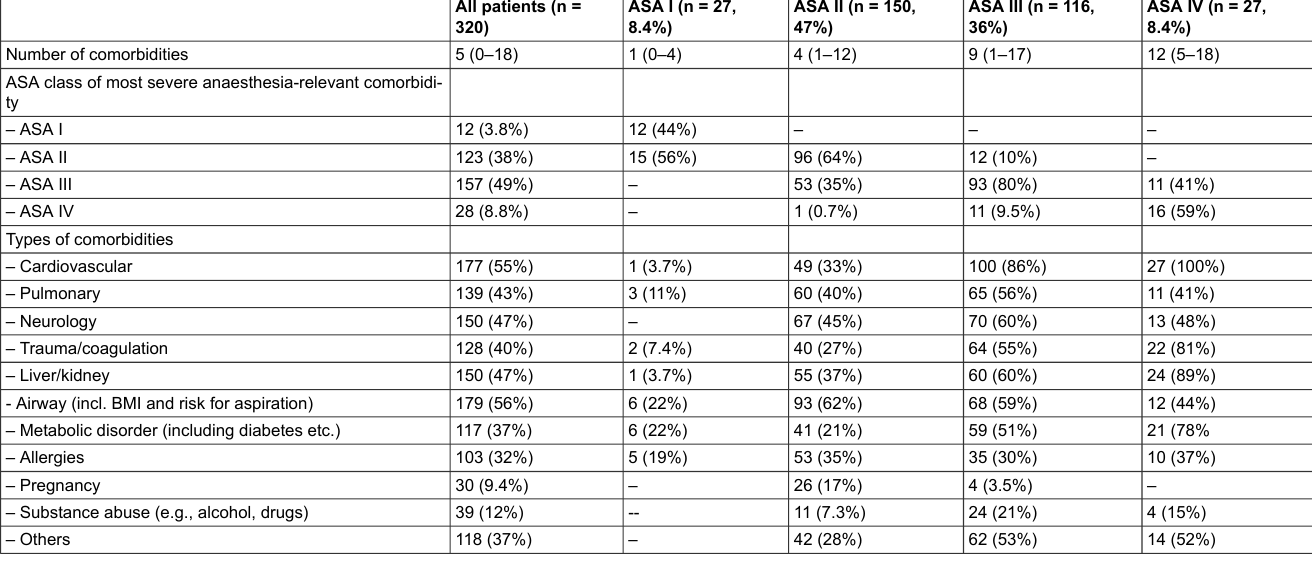
Table 2: Comorbidities for the total study population (n = 320) and for the different ASA PS classes This table gives an overview of the number and severity of anaesthesia-relevant comorbidities. An ASA class was assigned to each comorbidity by the study team. The columns correspond to the overall ASA PS classes as preoperatively assigned by the treating anaesthesiologists. Quantitative variables are reported as median (IQR), quantitative as number